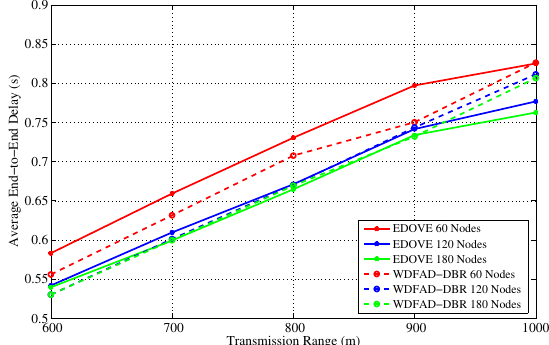
Figure 24. End-to-End delay between Source node that generated data message and Sink node versus the transmission